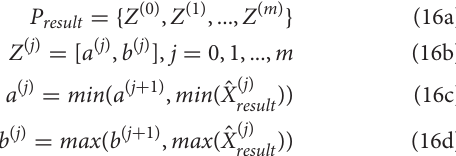
Figure 2 . The final arrays describing the membership level j are constructed as